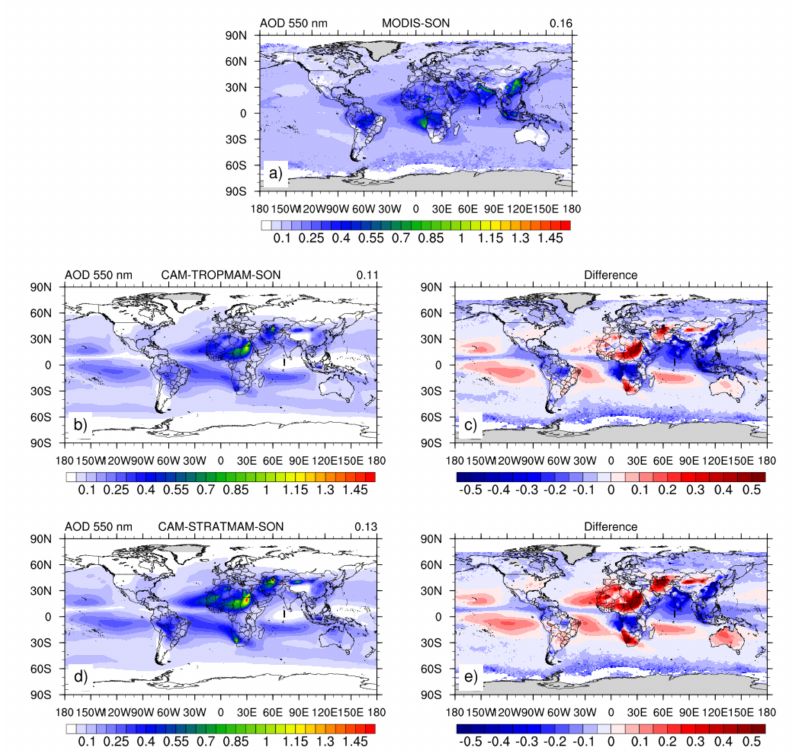
Figure 9. ( a ) AOD observed by MODIS sensor for September-October-November